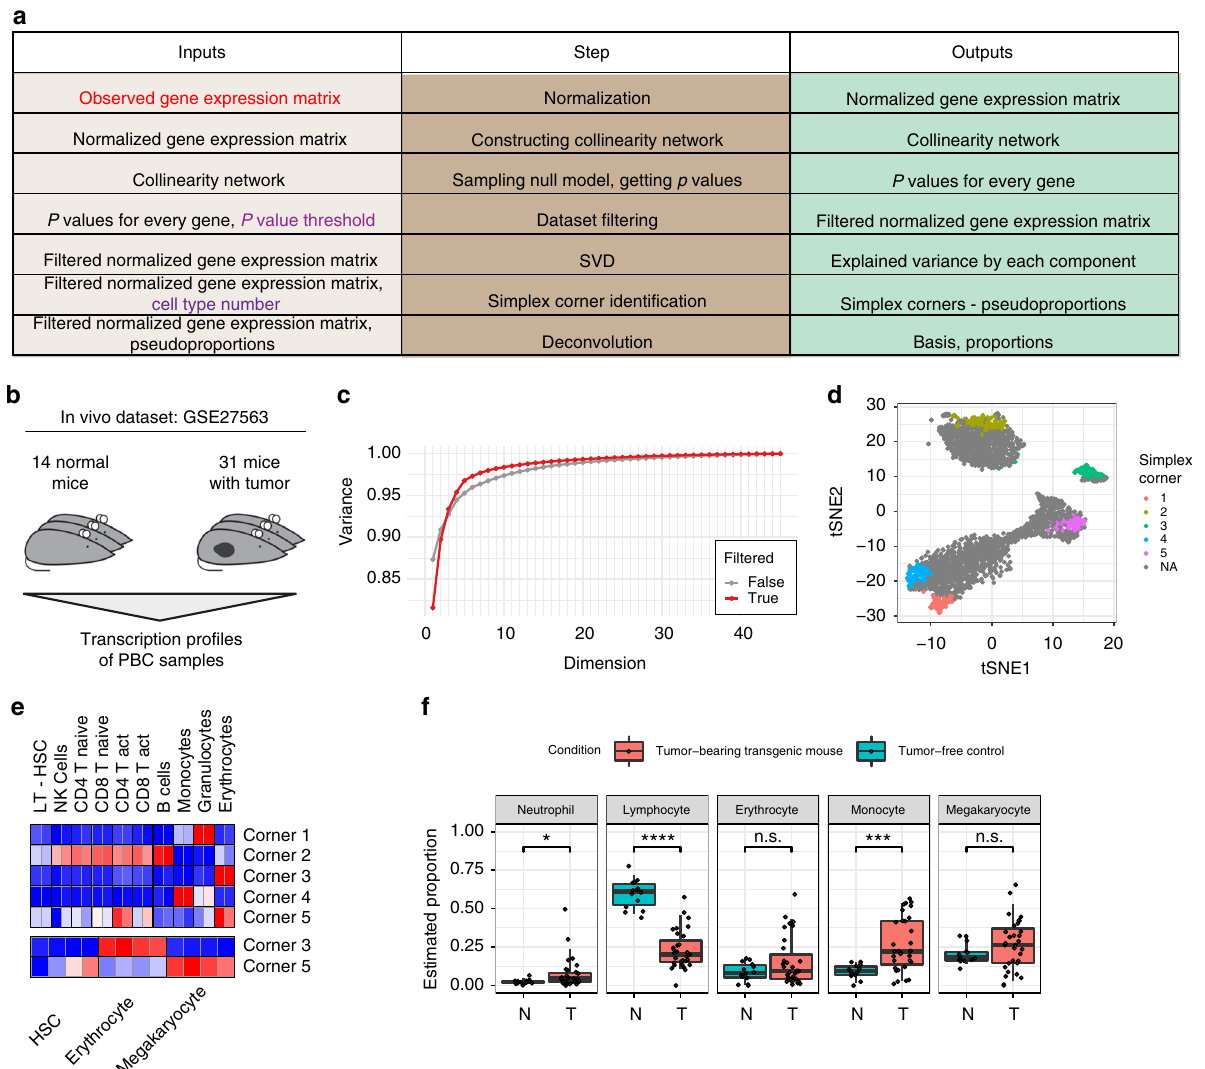
Fig. 6 Complete deconvolution pipeline is able to dissect realistic datasets. a Pipeline steps required to perform complete deconvolution. b Schematic of GSE27563 dataset. c First fi ve components of SVD of the fi ltered dataset explain more that 97% of the variance. Closest 100 genes to each simplex corner for panels d and e . d TSNE dimensionality reduction can be used to highlight the structure of high-dimensional fi ltered dataset. e We used datasets GSE27787 for mouse hematopoietic cells, and GSE49664 for erythrocyte-related population to identify cell types in the mixture. Heatmaps show averaged z -score of identi fi ed gene sets in population presented in the datasets. Values are from gene set minimum (blue) to gene set maximum (red). f Box and dot plot for deconvolution results, showing changes between normal and tumor-bearing mice. For each boxplot bottom whisker, bottom of the box, middle line, top of the box, and top whisker are 5%, 25%, 50% (median), 75%, and 95% quantiles respectively. Group comparisons were determined using a